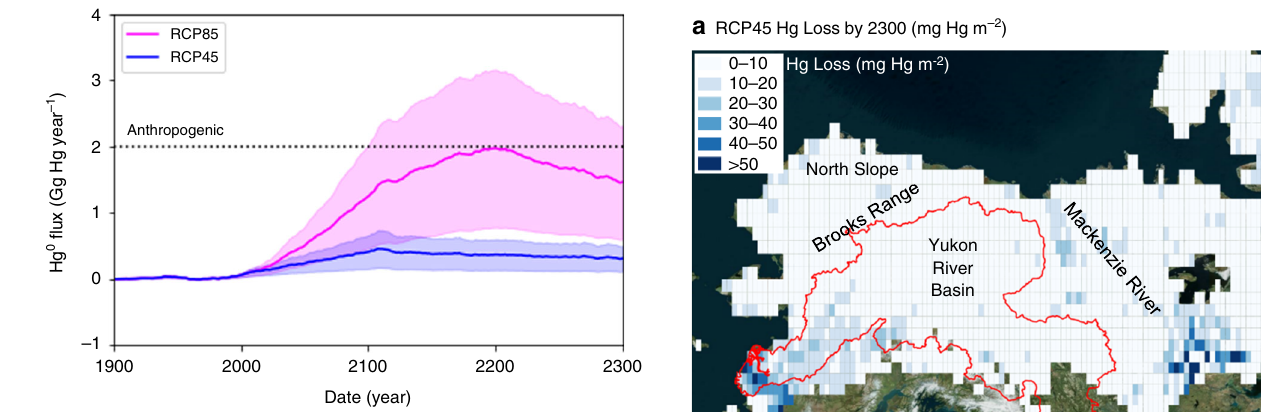
Fig. 2 Annual net elemental mercury (Hg 0 ) fl ux into the atmosphere. The net fl ux is Hg 0 evasion into the atmosphere minus Hg 0 deposition from the atmosphere, summed across all permafrost regions. The shaded areas represent uncertainty in the net Hg 0 fl ux and the dashed line represents current global anthropogenic emissions.